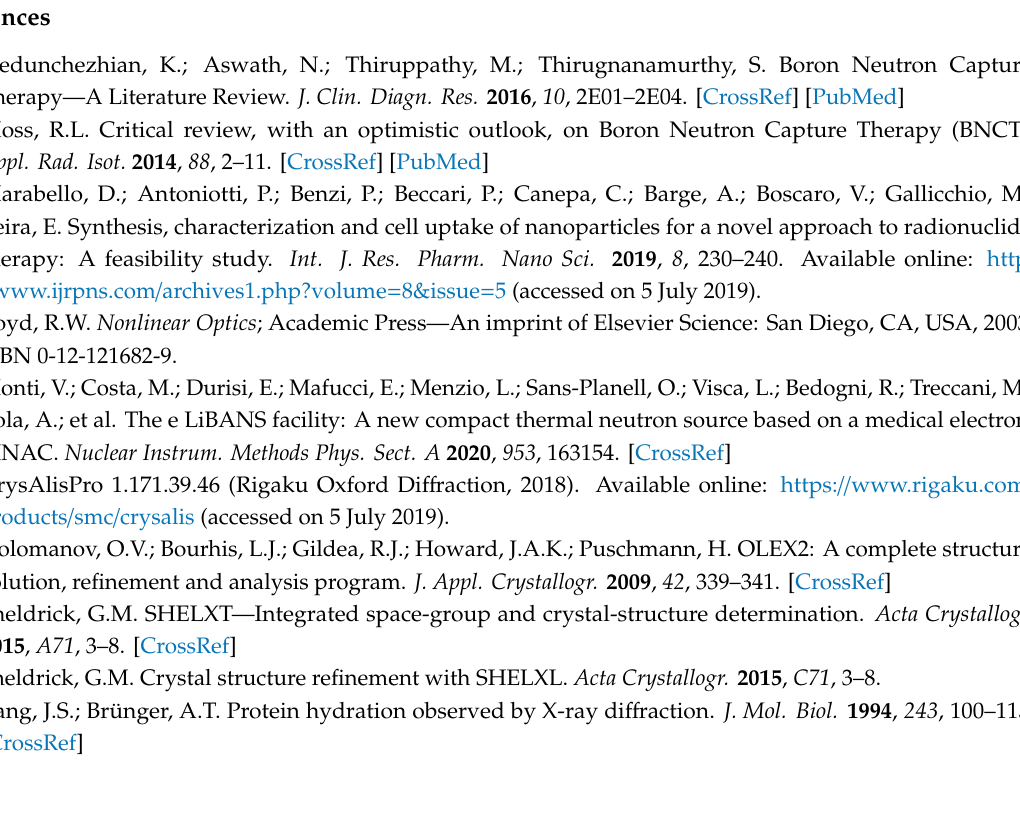
Table S1: Crystal data and structure refinement for LiM 2 B, Table S2. Bond lengths for LiM 2 B from X-ray di ff raction and theoretical calculations, Table S3: Bond angles for LiM 2 B from XRD, Table S4: Crystal data and structure refinement for Li 5 T 2 B, Table S5: Bond lengths for Li 5 T 2 B from X-ray di ff raction and theoretical calculations, Table S6: Bond angles for Li 2 B Figure S2: View of the Li 5 T 2 B